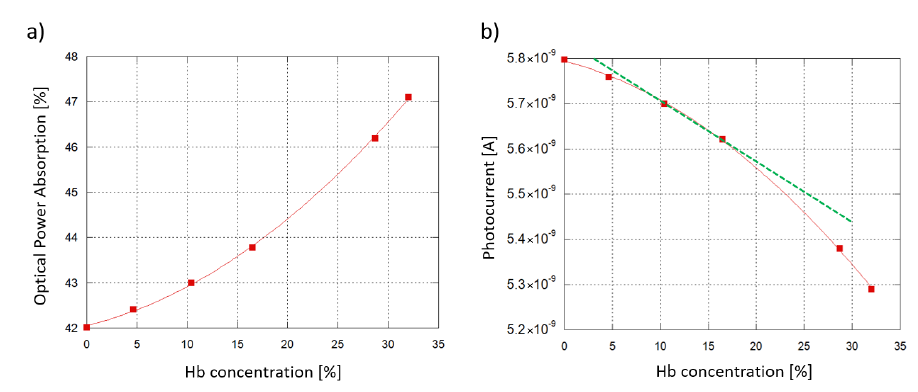
Figure 10. Sensing demonstration: 6 hemoglobin-water samples at different concentrations interact- ing with the SU-8 waveguide. A 6mm-long interaction site and a 5 µ m-thick SU-8 waveguide are considered. ( a ) Modeled optical power absorption from the sample plotted as a function of the Hb concentration in water. ( b ) a-Si:H diode photoresponse vs. Hb